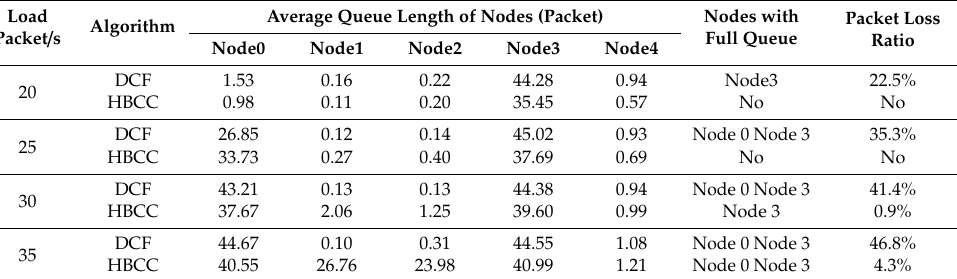
Table 3. Queue status of nodes.